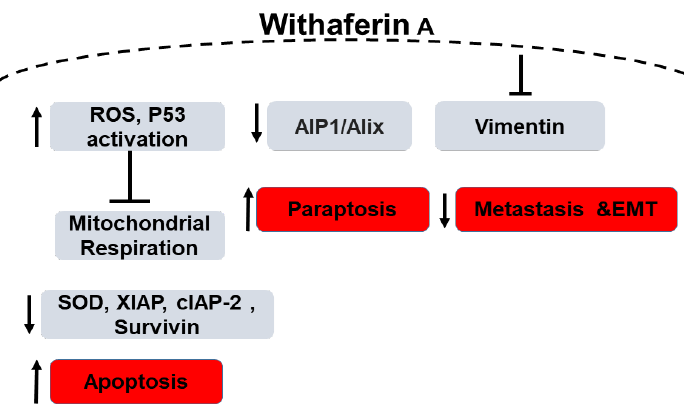
Figure 2. Schematic diagram of the role of Withaferin A in Breast Cancer. “ ↑ ” denotes an increase, “ ↓ ” denotes decrease and “T” denotes inhibition.